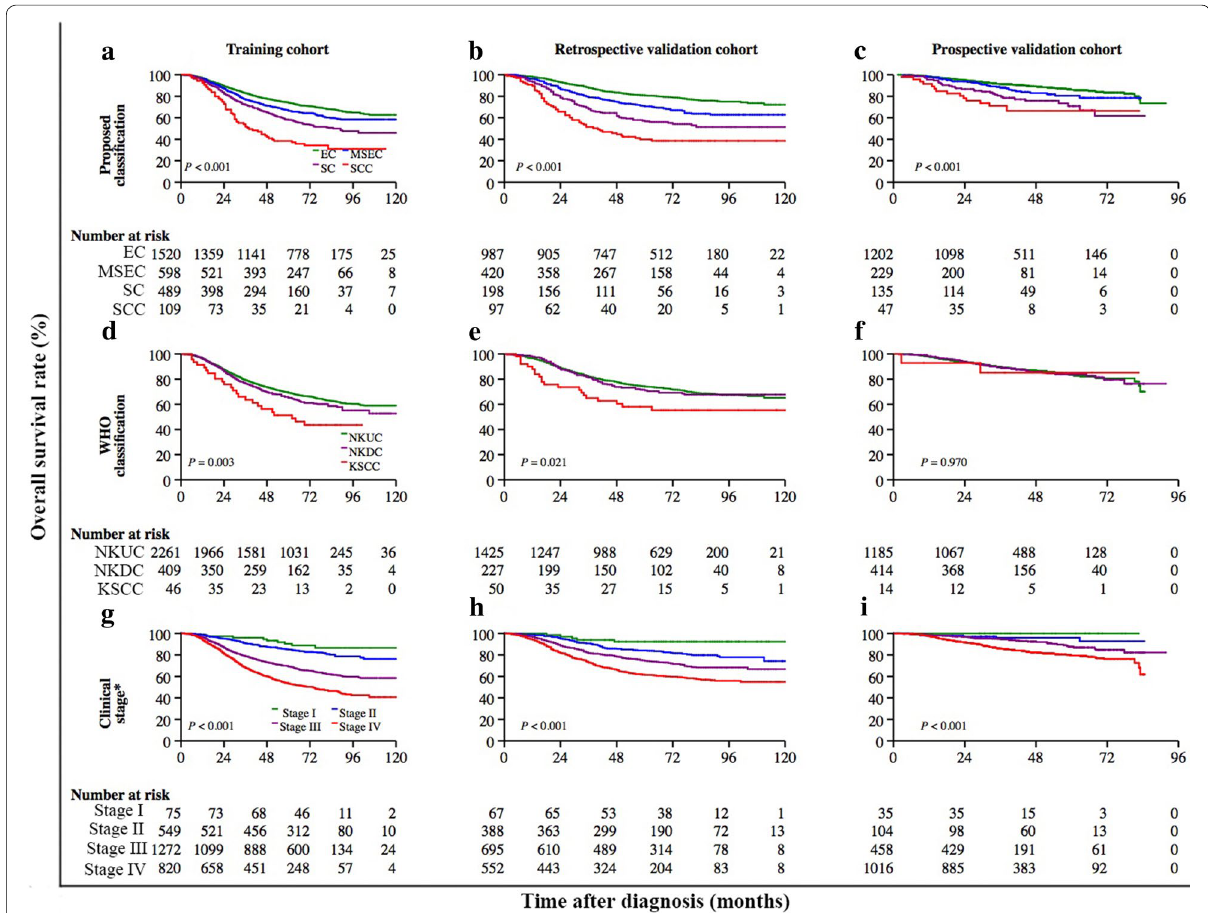
Fig. 3 Kaplan‑Meier curves of OS according to the proposed classification, the World Health Organization (WHO) classification, and clinical stage in NPC patients from the training ( n 2716), retrospective validation ( n 1702), and prospective validation cohorts ( n 1613), respectively. OS = = = curves of patients classified with the proposed classification in the training ( a ), retrospective validation ( b ), and prospective validation cohorts ( c ). OS curves of patients classified with WHO classification in the training ( d ), retrospective validation ( e ), and prospective validation cohorts ( f ). OS curves of patients classified with clinical stage in the training ( g ), retrospective validation ( h ), and prospective validation cohorts ( i ). The log‑rank test was used to estimate P values. *The training cohort was classified by the 1992 China staging system; the retrospective validation cohort was classi‑ fied by the 1992 China staging system or the 1997 American Joint Committee on Cancer (AJCC) staging system; the prospective validation